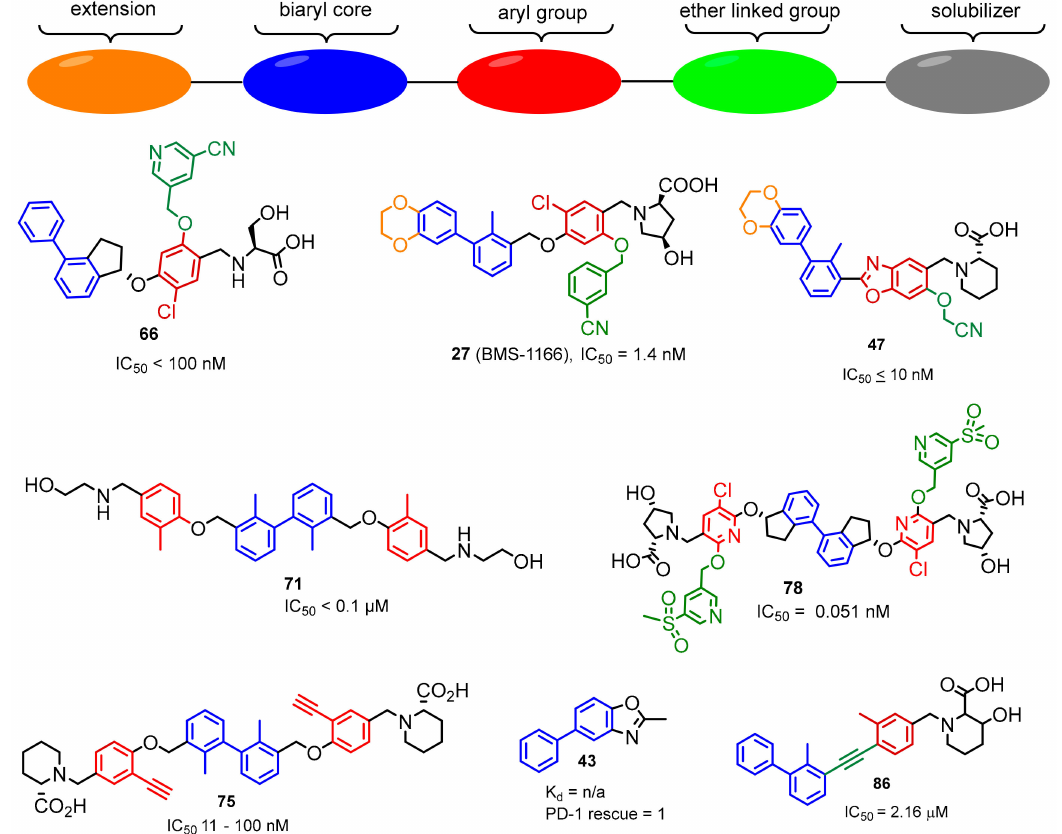
Figure 37. The general pattern in the development of PD-L1